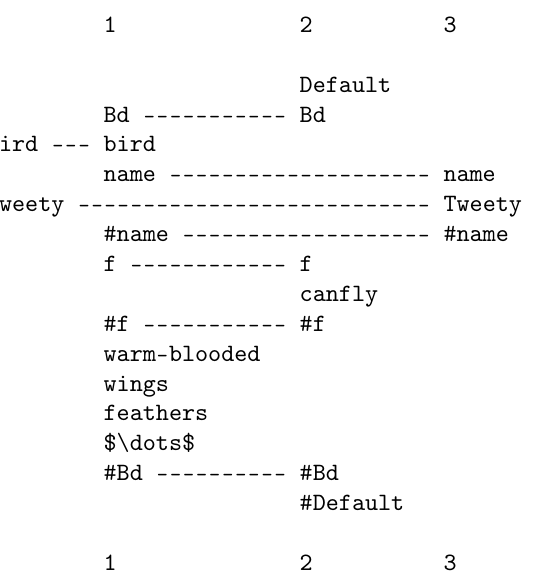
Figure 8. One of the three best SPMAs formed by the SPCM from the New SP-pattern shown in column 0, ‘ bird Tweety ’, and a repository of Old SP-patterns describing information about birds in general and more specific kinds of birds such as ostriches and penguins. Reproduced from ([2], Figure 7.10).